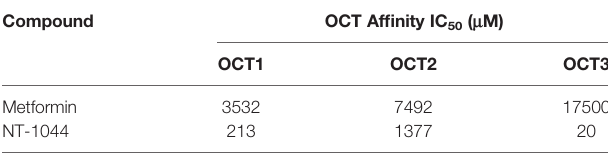
TABLE 1 | Potency of metformin versus